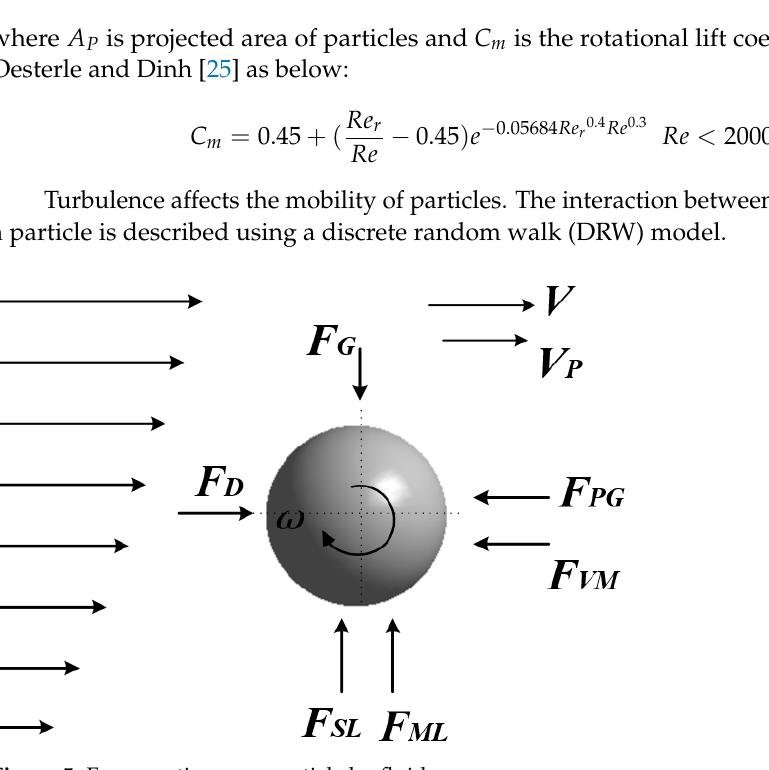
 represents particle velocity. VM F P V sents fluid’s drag force on particle. G F  represents Magnus force generated by particle rotation. ML F